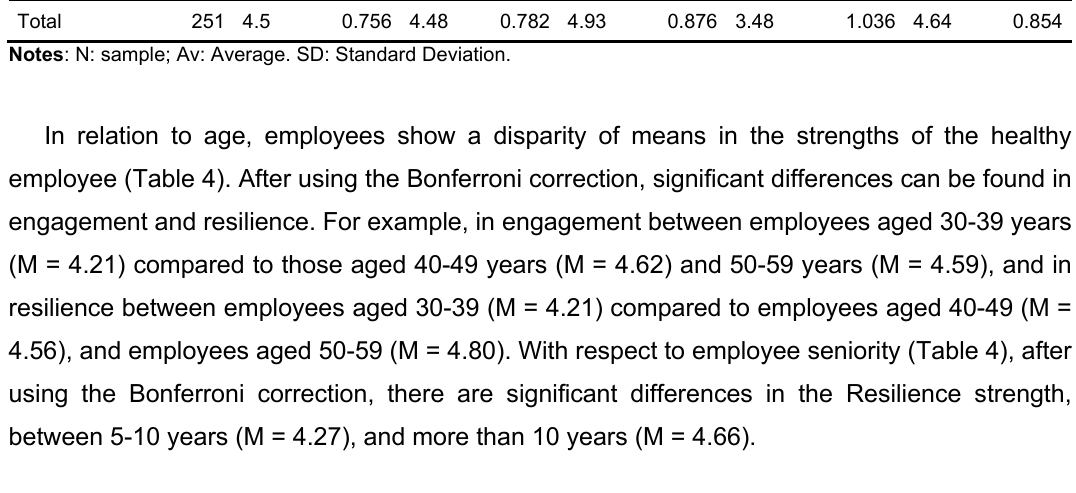
Engagement Resilience Self-efficacy Positive emot.